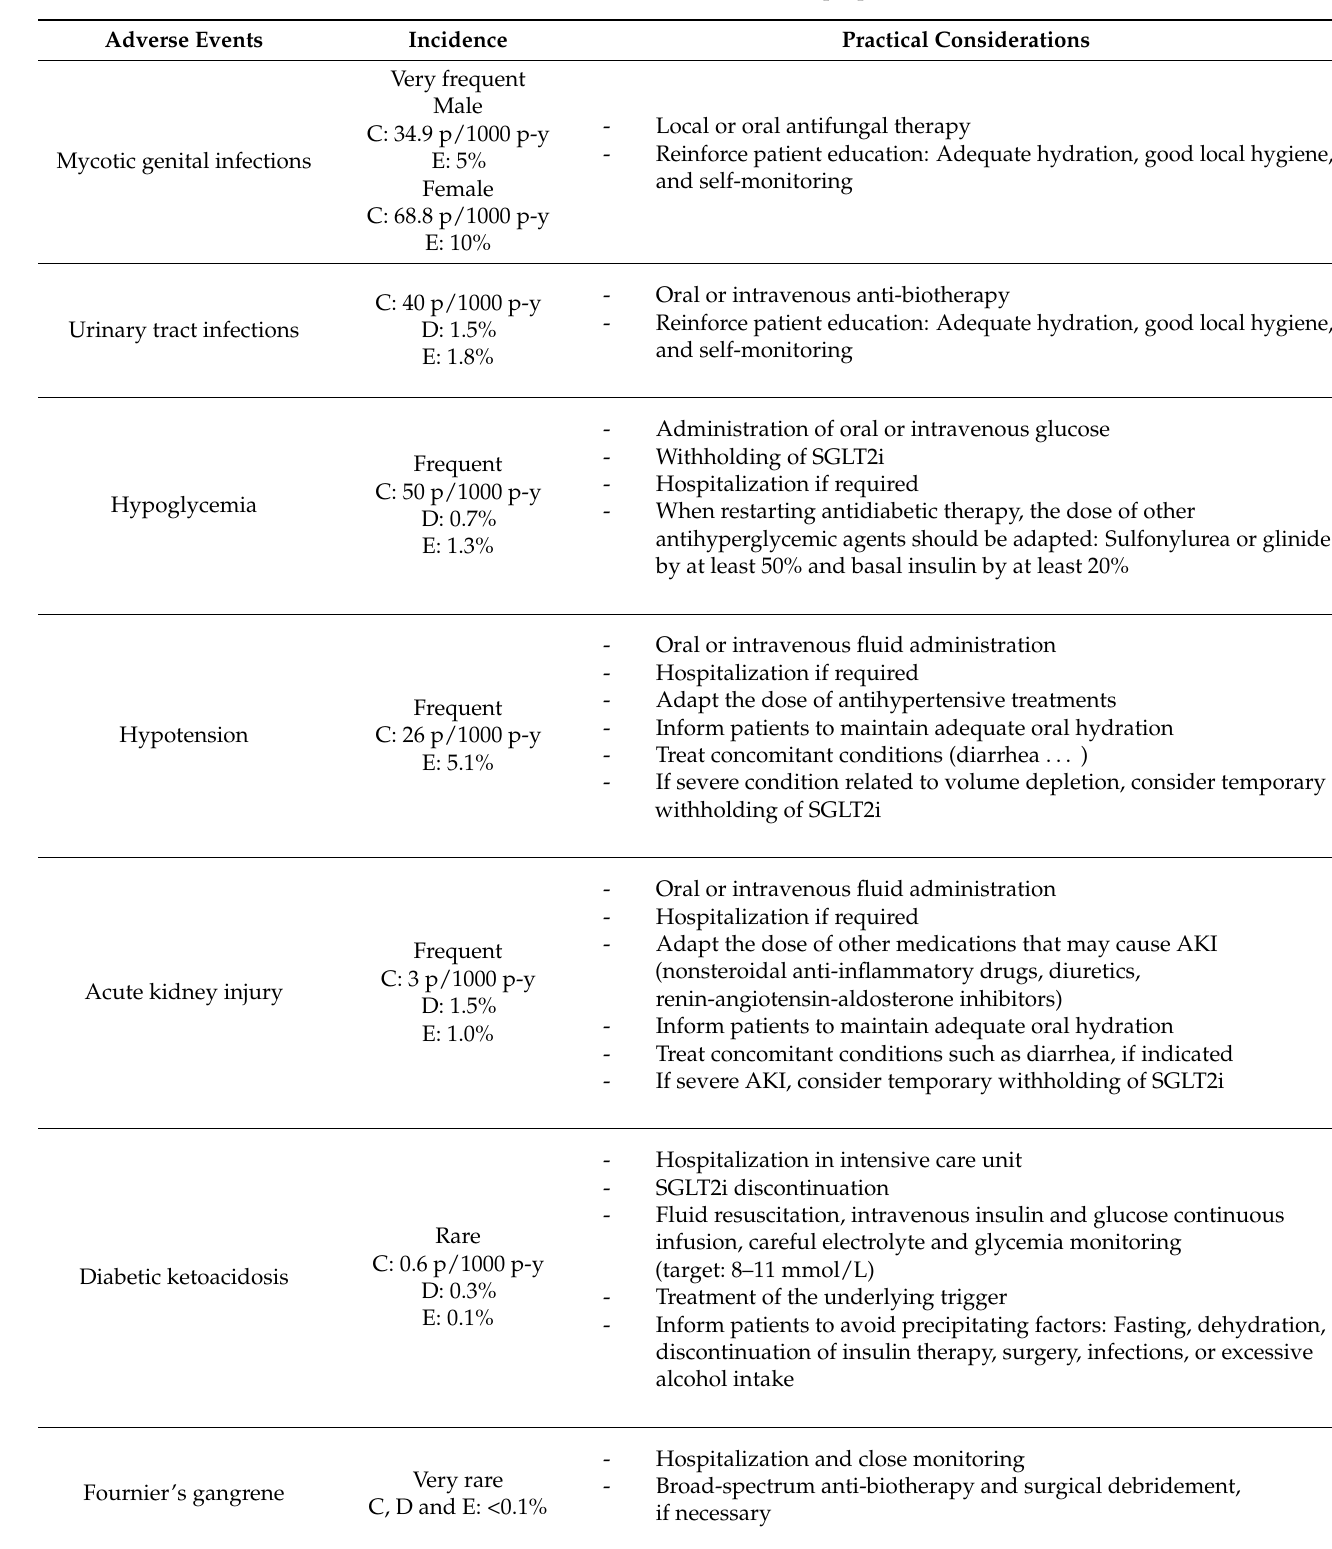
Table 2. Adverse events associated with SGLT2is and proposed courses of